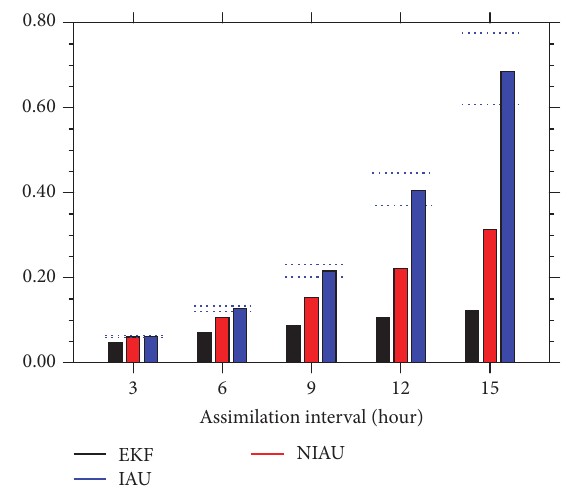
Figure 4: The time averaged (from day 0 to day 10) RMSE with respect to the assimilation interval using the EKF (black bar), the NIAU (red bar), and the IAU (blue bar) methods. Note that the dotted line denotes the 95% confidence level of the IAU using a bootstrap